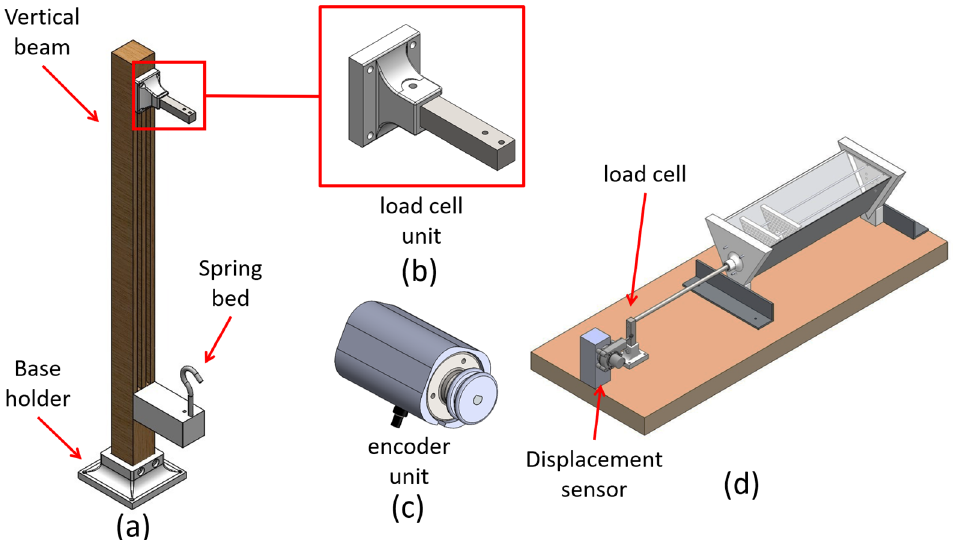
Figure 5. CAD model for ( a ) force and displacement of NiTiNOL springs assessment platform, ( b ) load cell extension unit, ( c ) encoder extension unit, and ( d ) solar-driven thermomechanical SMA actuator assessment platform.